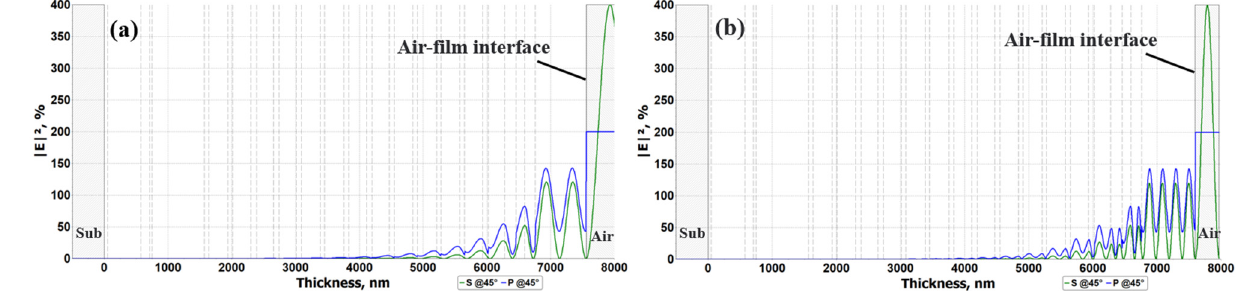
Figure 4. Electric field distributions at 1064 nm ( a ) and 532 nm ( b ) for AOI = 45°.